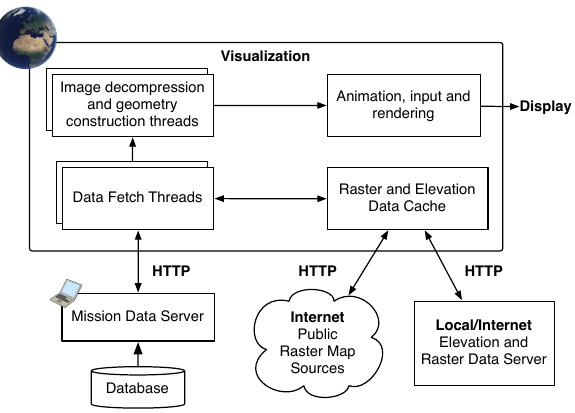
Figure 4: The visualization’s design.